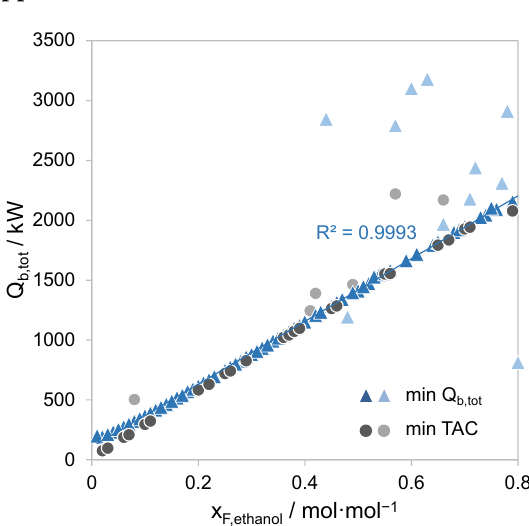
Figure A1. Set of solutions for the heteroazeotropic distillation of ethanol and water using cyclohex- ane as solvent. The blue triangles represent intermediate results during the polylithic solution strategy without cost and sizing equations, considering the total reboiler duty as the objective function. The circles mark the final results after the structural optimization w.r.t. the total annualized costs (TAC). The light-gray circles correspond to the outliers in Figure 7.